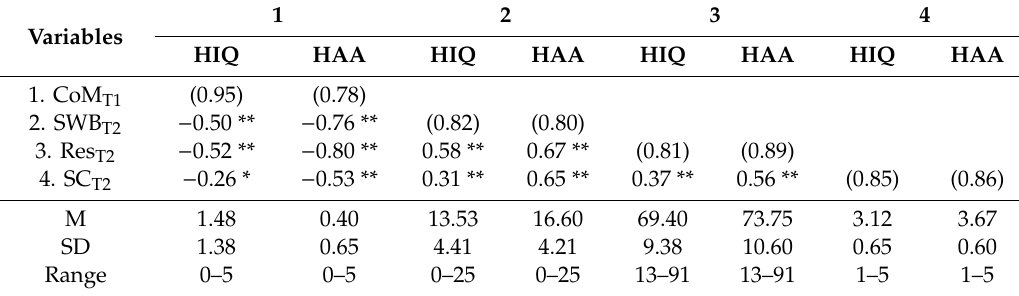
Table 1. Pearson correlations, means, standard deviations, and